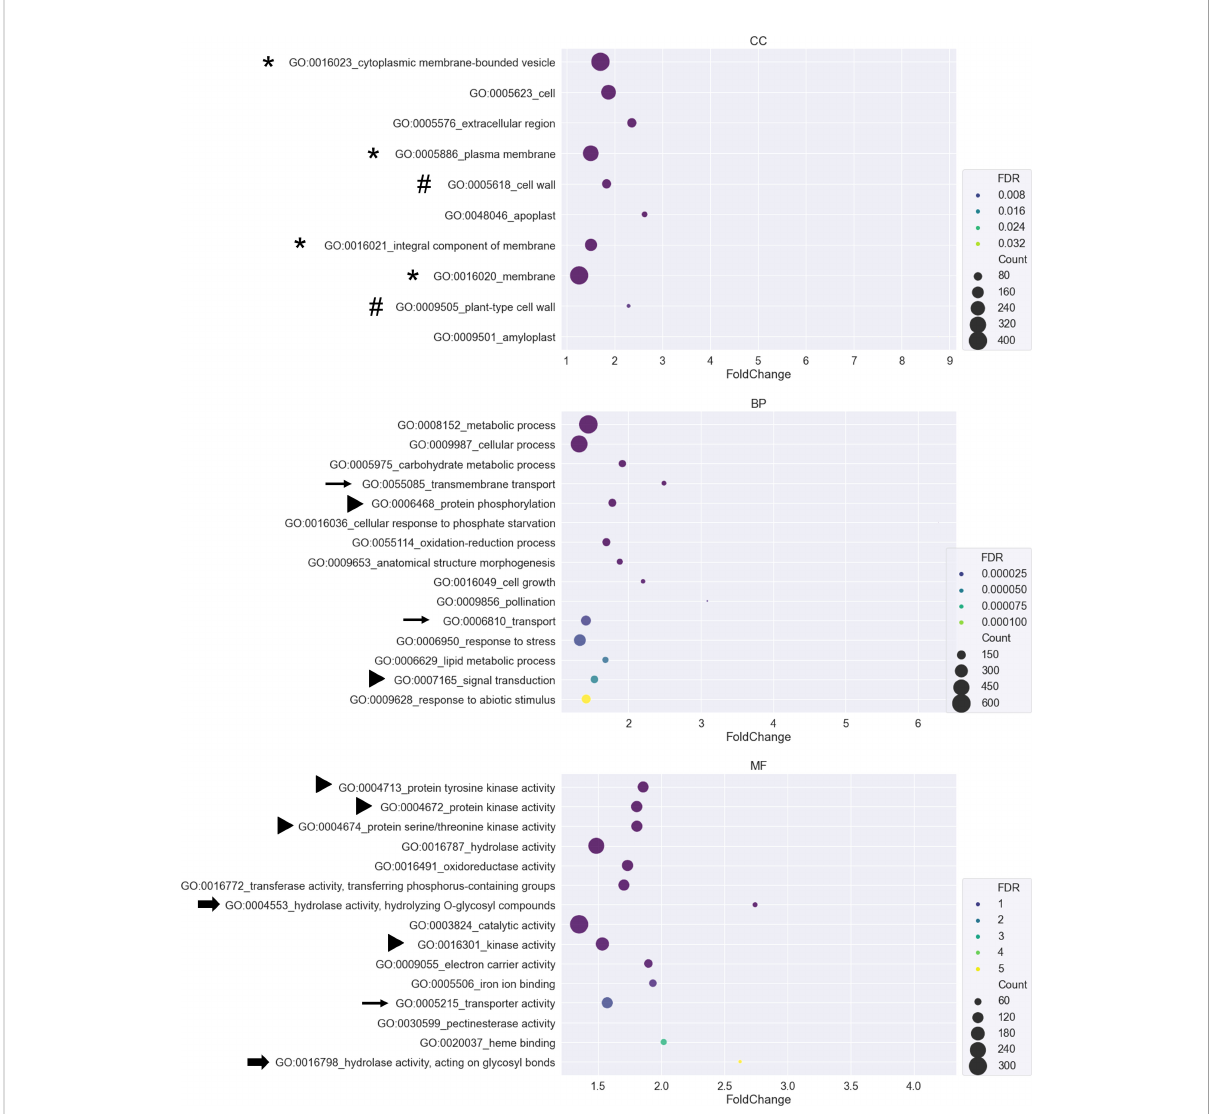
FIGURE 4 GO enrichment analysis for DEGs from region 7 A bubble plot was used to visualize the Gene Ontology (GO) enrichment analysis of DEGs belonging to region 7. GO terms from the cellular component (CC), biological process (BP), and molecular function (MF) categories were plotted. The X-axis represents the fold change of the GO enrichment level of the gene set over the background. The size of the bubbles represents the number of genes. The color of the bubbles represents the false discovery rate (FDR). GO terms with FDR greater than 0.05 were removed from the list. Only the 10-15 GO terms with the smallest FDR value were visualized in each category. Symbols in front of GO terms showed that these GO terms shared similar